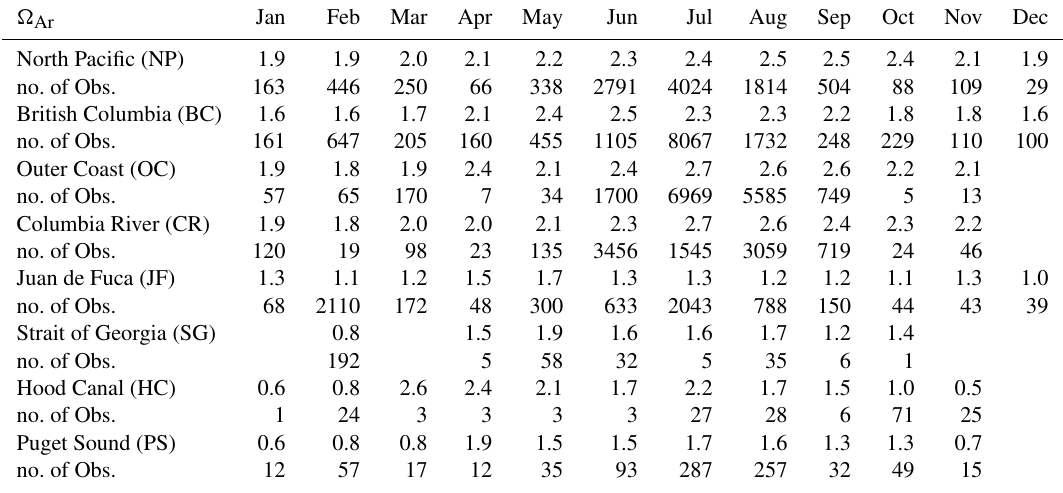
Table B7. Average monthly (cid:127) Ar seasonal cycles for the eight unique regions. The total number of observations (no. of Obs.) contributing to the monthly average estimate is included.